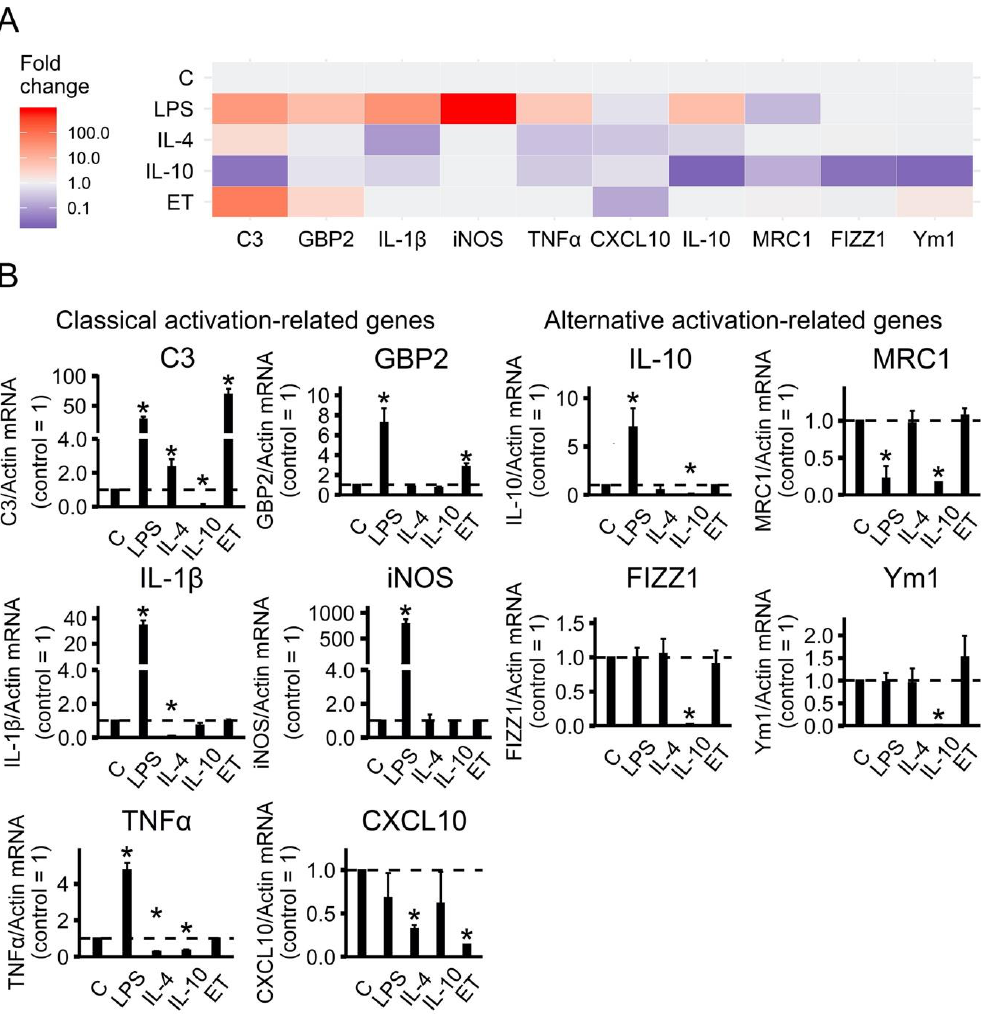
Figure 1. Identification of astrocytes polarization state in primary rat astrocyte cultures based on gene-expression profiles. ( A ) Heat map representation; ( B ) quantitative analysis of expression data. The primary rat astrocyte cultures were treated with lipopolysaccharide (LPS, 100 ng/mL), interleukin 4 (IL-4, 10 ng/mL) or interleukin10 (IL-10, 20 ng/mL) for 24 h or adapted to endotoxin in the tolerance model (ET, LPS 10 ng/mL, 48h), and the total RNAs were isolated. The mRNA levels of polarization state markers ( C3, GBP2, IL- 1β, iNOS, TNFα, CXCL10, IL -10, MRC1, FIZZ1 and Ym1 ) were determined